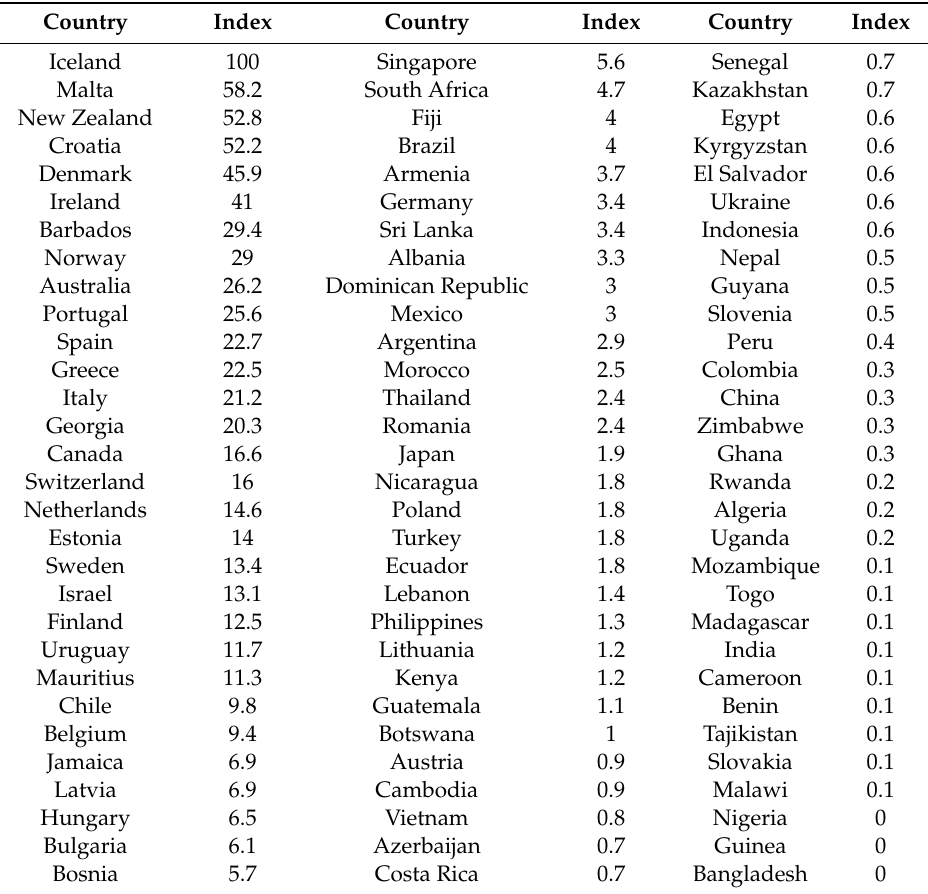
Table 2. List of countries included in the